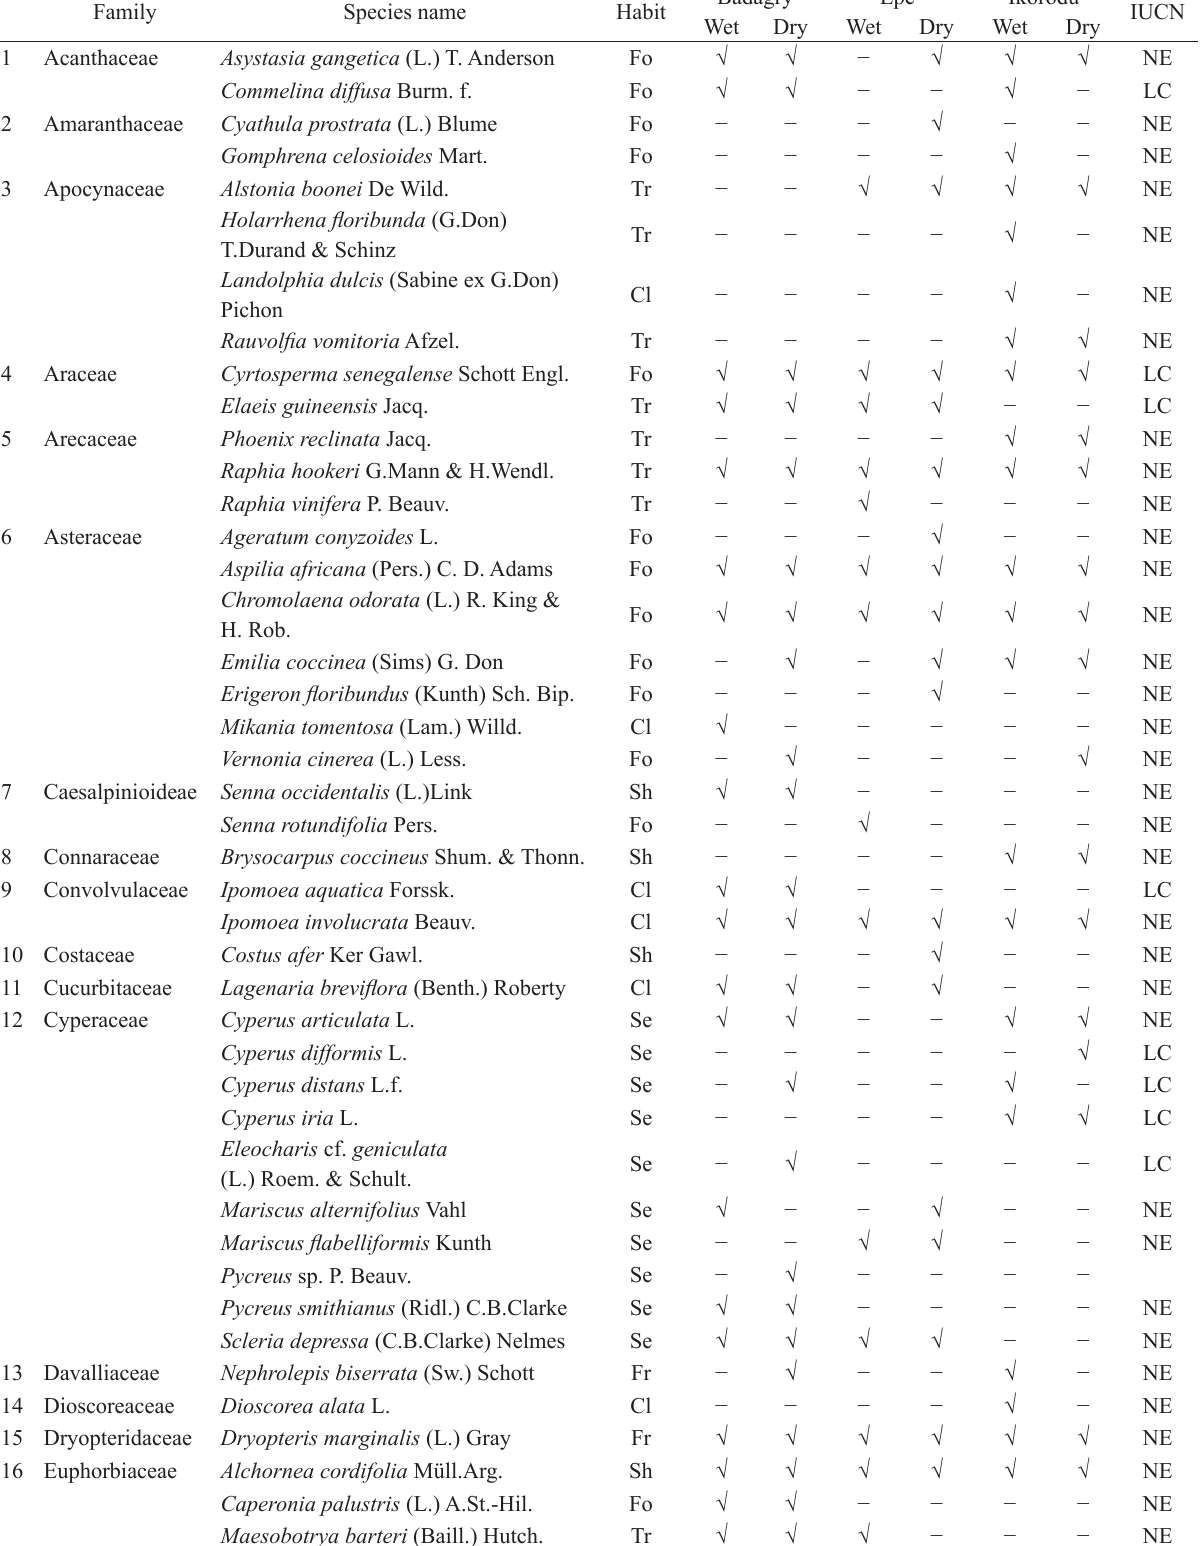
Table 2. Distribution and IUCN conservation status of encountered flora species during field survey. Abbreviation are: NE, Not evaluated; LC, Least concern; VU, Vulnerable; Cl, Climber; Gr, Grass; Tr, Tree; Fo, Forb; Fr, Fern; Se, Sedge; Sh, Shrub. Family Species name Habit